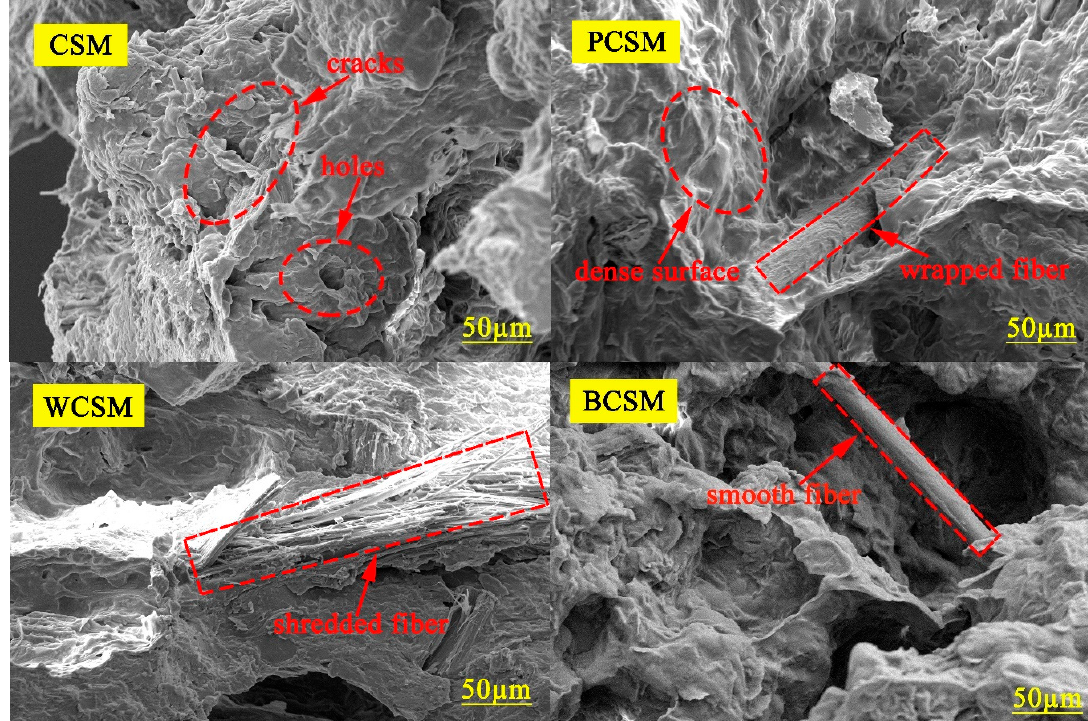
Figure 3. SEM images of surface morphology for cured CSM, PCSM, WCSM, and BCSM adhesive samples.